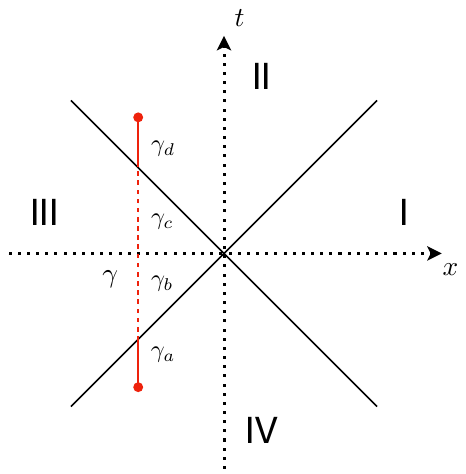
Figure 4 . Four regions of a two-dimensional slice of Minkowski space. The Bondi coordinates with r > 0 cover only region II and part of region III. When r ∈ ( −∞ , ∞ ) , the Bondi coordinates cover regions II, III, and IV. We also show the image of the bench under the map (D.4). For small J , the bench γ = γ a ∪ γ b ∪ γ c ∪ γ d ends in Region II and IV. The segment in the middle is dashed as it corresponds to analytically continued complex coordinates ( u, r, φ )